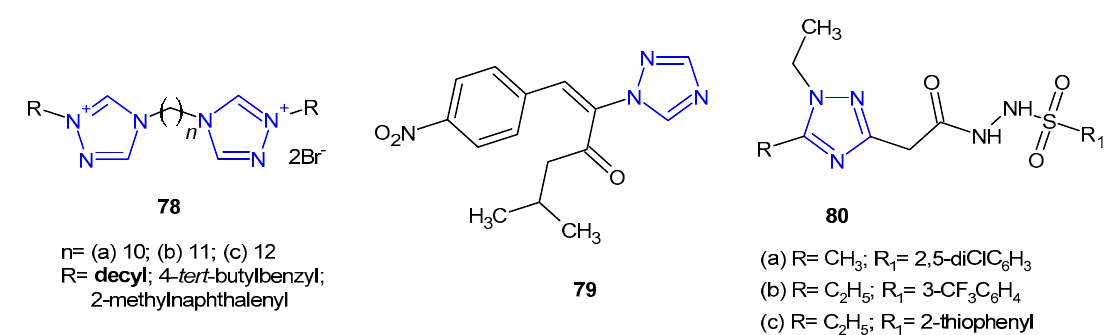
Figure 24. Miscellaneous 1,2,4-triazoles with antibacterial activity.